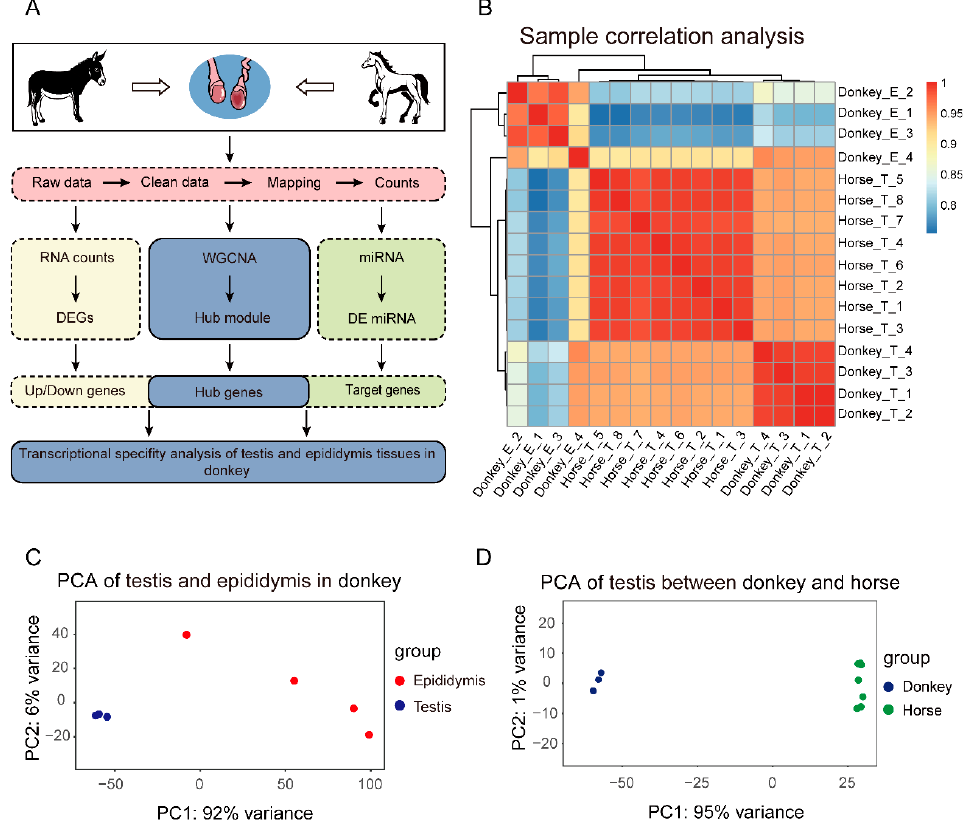
Figure 1. The gene expression landscape based on the transcriptome data of different tissues. ( A ) The research flow chart of collected transcriptome data in this study. ( B ) Hierarchical clustering of gene expression matrices for all samples including testis and epididymal tissues of the donkey, and horse testis tissue. ( C ) Principal component analysis (PCA) of donkey testis and epididymis tissues. ( D ) PCA of testis tissues between donkey and horse.